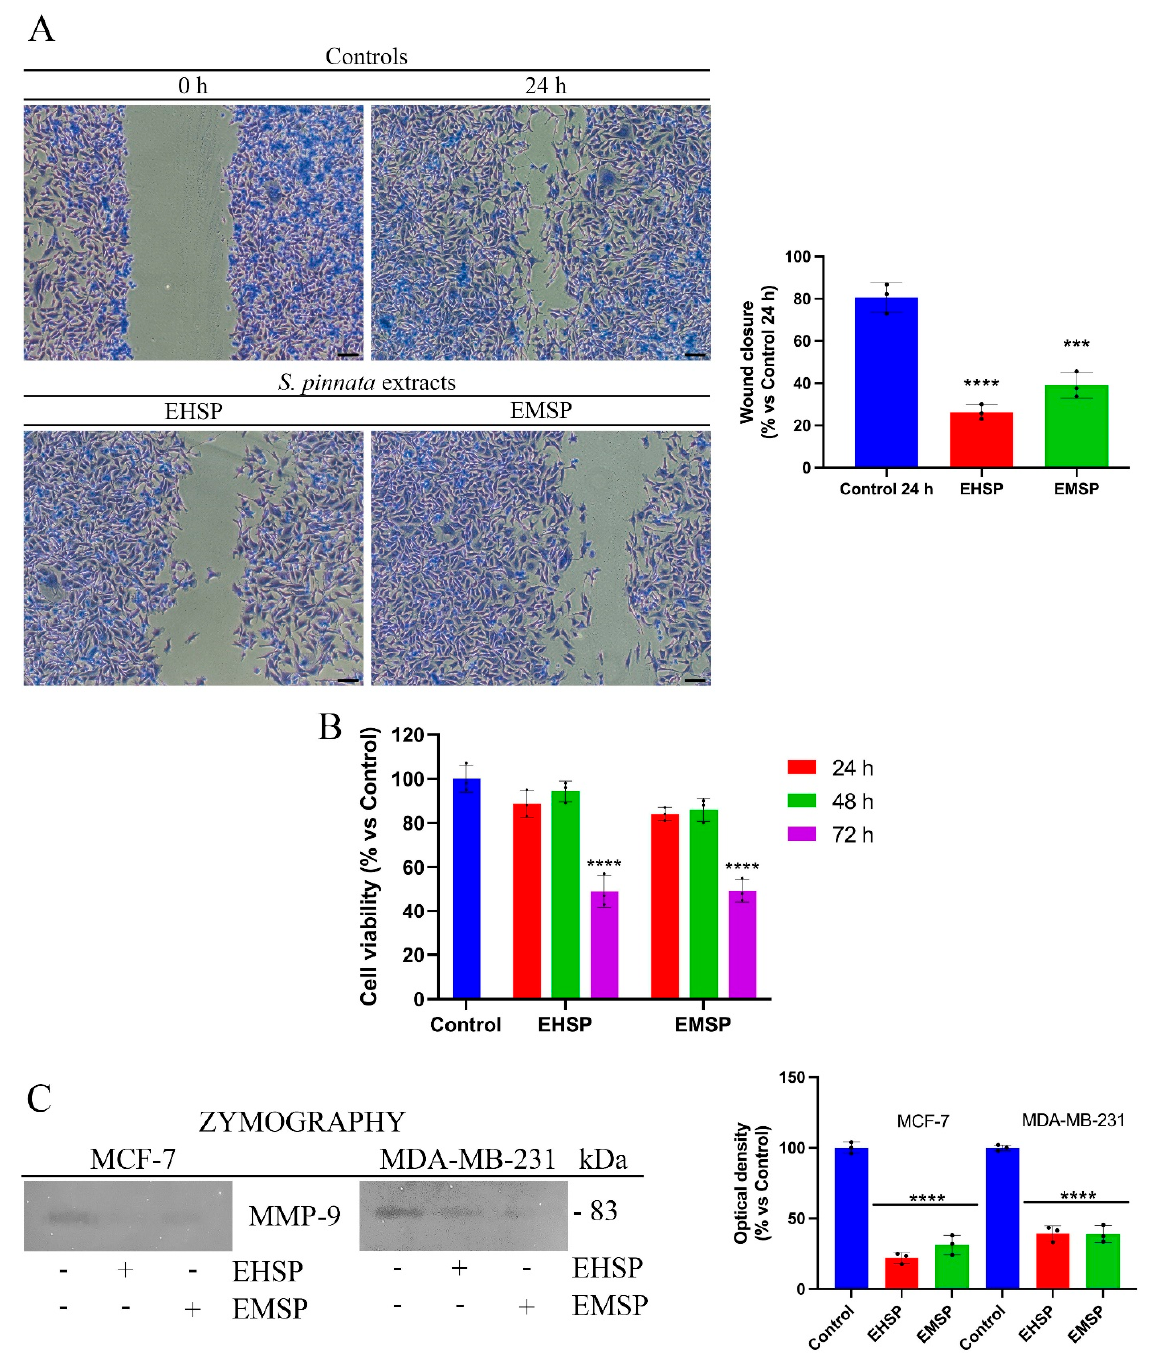
Figure 3. ( A ) Wound healing of MDA-MB-231 cells exposed to EHSP or EMSP, at IC 50 values, for 24 h. Pictures were taken at 10 × . Scale bars 50 µ m. Histogram represents the wound closure quantification. ( B ) Viability of MDA-MB-231 cells exposed to EHSP or EMSP, at IC 50 values, for 24, 48, and 72 h. ( C ) Gel-zymography of MCF-7 and MDA-MB-231 exposed to EHSP or EMSP at IC 50 values for 24 h. MCF-7 cells were pre-treated with 80 ng/mL PMA for 24 h. Histogram represents gel-zymography quantification in MCF-7 and in MDA-MB-231. Values represent means ± SD from three independent experiments ( n = 3). Statistical analysis was performed using one-way ANOVA analysis. *** p < 0.001; **** p <